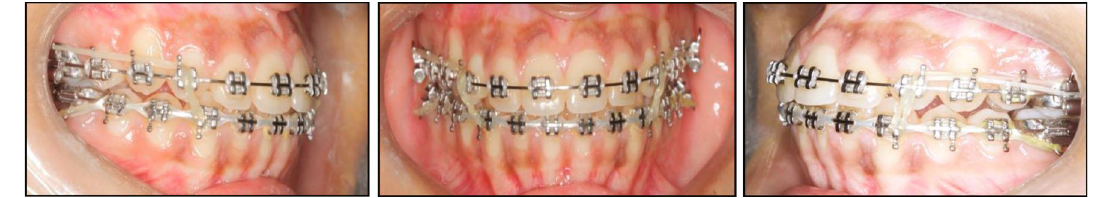
Figure 11: L-shaped elastic chain from lower canine to upper molar on both